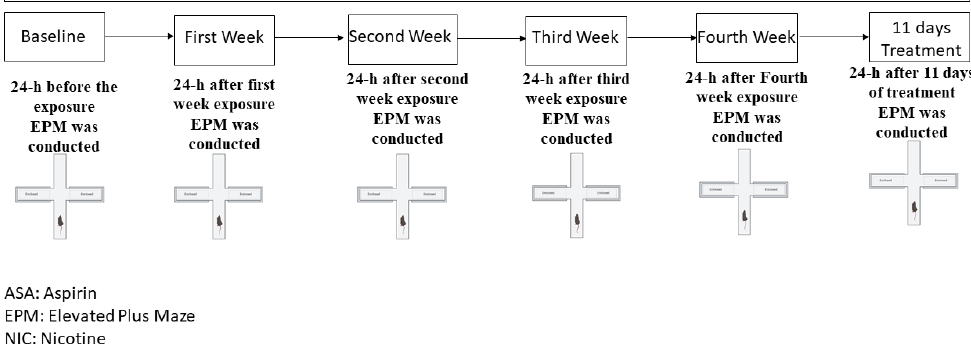
Figure 2. Experimental timeline for cigarette exposure, aspirin treatment, and EPM testing. Rats were randomly divided into four groups after baseline; (1) control: room air exposed + distilled water (1 mL) treatment, (2) NIC: exposed to cigarette smoke + distilled water (1 mL) treatment, (3) NIC/aspirin: exposed to cigarette smoke + aspirin 30 mg/kg treatment, (4) aspirin: room air + aspi- rin 30 mg/kg treatment.